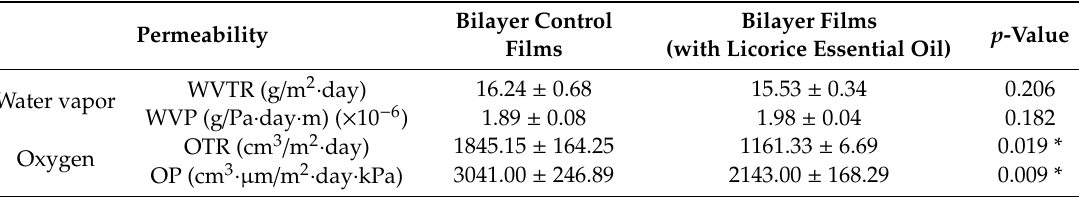
Table 3. Barrier properties of bilayer